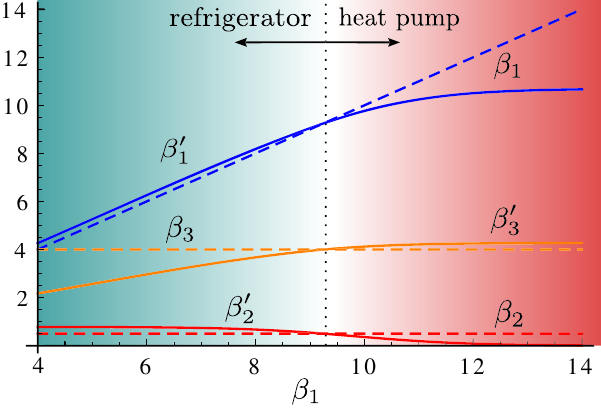
FIG. 5. Comparison between the inverse effective (or virtual) temperatures β 0 (solid lines) and the real inverse temperatures of r the reservoirs β (dashed lines) for r ¼ 1 , 2, 3 (blue, red, orange), r as a function of β 1 when ℏ ω 1 ¼ 1 and ℏ ω 2 ¼ 1 . 5 . In the refrigerator regime, the transition g ↔ e is, at an effective A temperature, colder than the coldest reservoir, β 0 1 ≥ β 1 , inducing heat extraction from it, while the other transitions induce dissipation of heat to the reservoir at intermediate temperature, β ≥ β 0 β 0 ≥ β 2 2 . In the 2 , and absorption of heat in the hotter one, 2 heat pump regime, the three heat flows change directions as the previous inequalities become